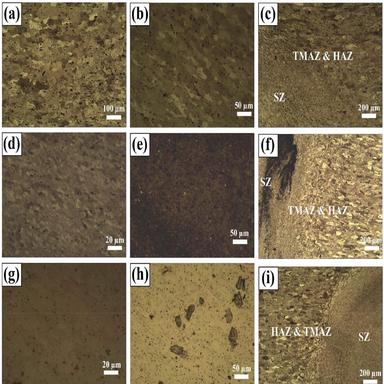
Optical microstructures across the (a-c) FSP modified aluminum alloy without reinforcing powder, (d-f) processed AA6061-20 wt% TiB2 single composite, and (g-i) processed AA6061-1 wt% Graphene-20 wt% TiB2 hybrid nanocomposite from (a-b, d-e, g-h) SZ and (c, f, i) HAZ/TMAZ.